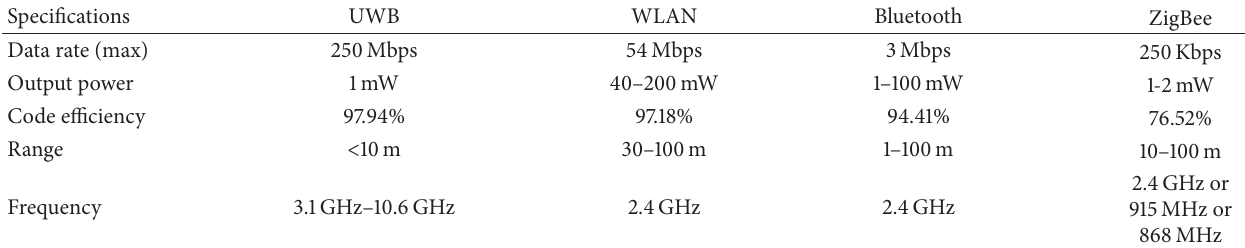
Table 6: Comparison of the physical layer standards in